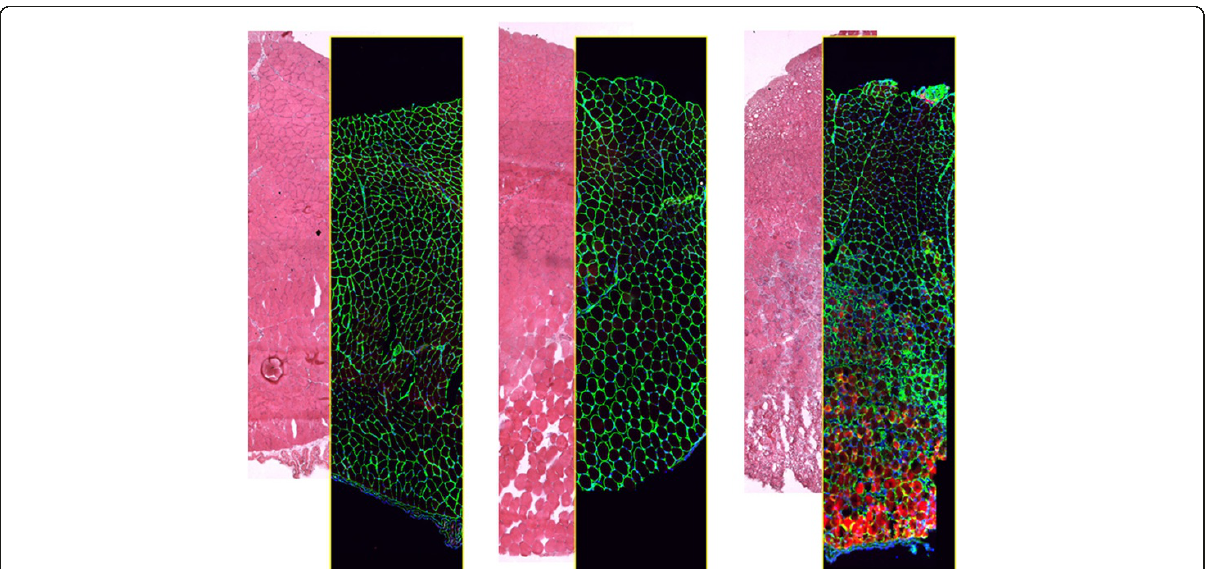
Figure 2 Integrity of the extra cellular matrix following muscle injury. Hematoxilin- and eosin-staining (H&E) and immunofluorescence localization of the membrane basement component laminin (green) on serial cross-sections of murine Tibialis anterior muscle (only a portion of the muscle is shown). Thirty minutes before fixation, the muscle was subjected to two types of physical injury: mechanical stress by crunching and tearing with forceps (LEFT) and freezing by applying a liquid nitrogen-cooled steel forceps to the surface (facing down in the picture) for 10 seconds (CENTER). Apart for the edema and fiber swelling visible in the images on the right, no major alterations of the basement membrane are seen following focal injury. In mice injected with Evans Blue Dye (EBD, RIGHT), injury muscle fiber necrosis (red) is apparent 8 h after freezing thanks to accumulation of EBD in the interior part of the damaged fibers. The muscle fibers die and are either renewed or replaced within the intact scaffold represented by the membrane basement, which wraps each fiber.